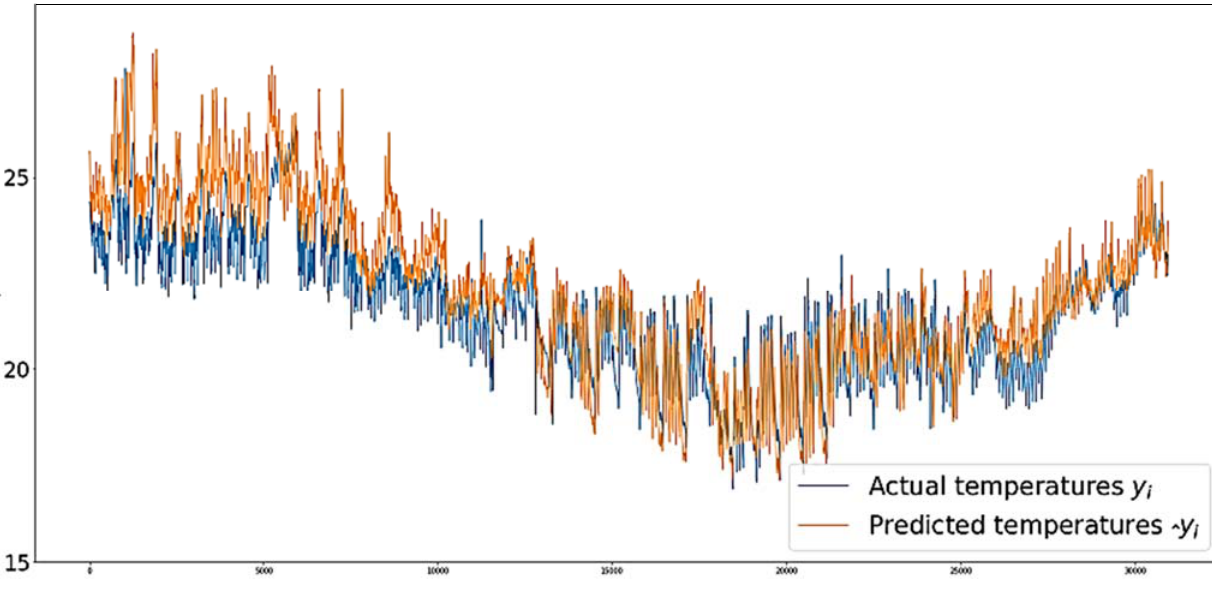
Figure 18. Plot of actual and predicted temperatures 2 h ahead for office 40 on the third floor.